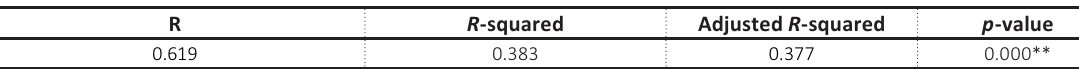
Table 20. Summary of adjusted R